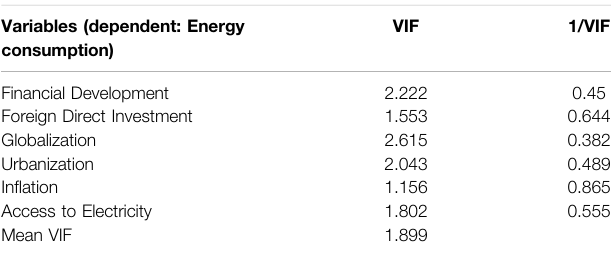
TABLE 4 | Variance in fl ation factor. TABLE 5 | Cross-sectional dependence test.